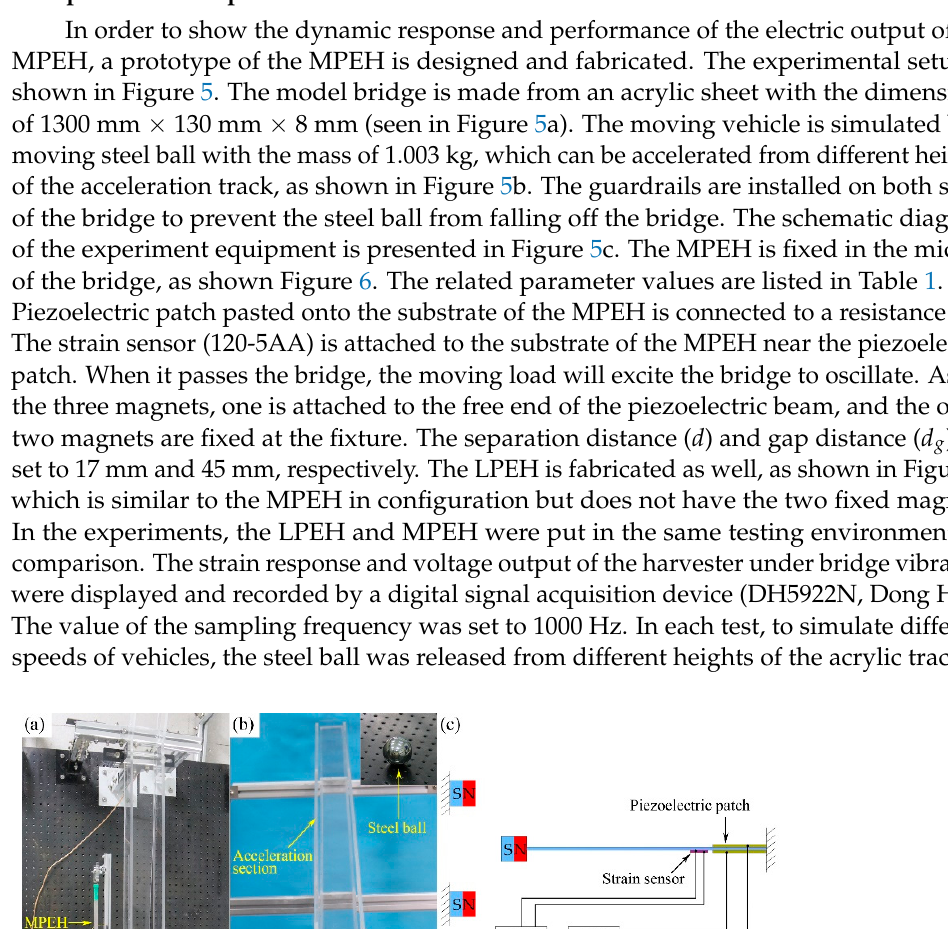
Figure 6. Prototype of the MPEH: ( a ) top view and ( b ) side view.